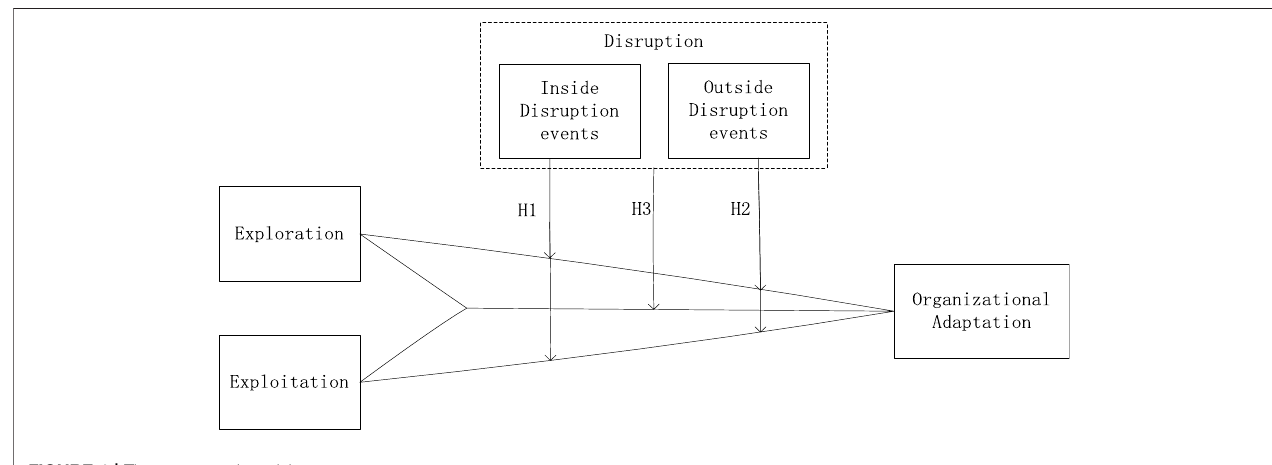
FIGURE 1 | The conceptual